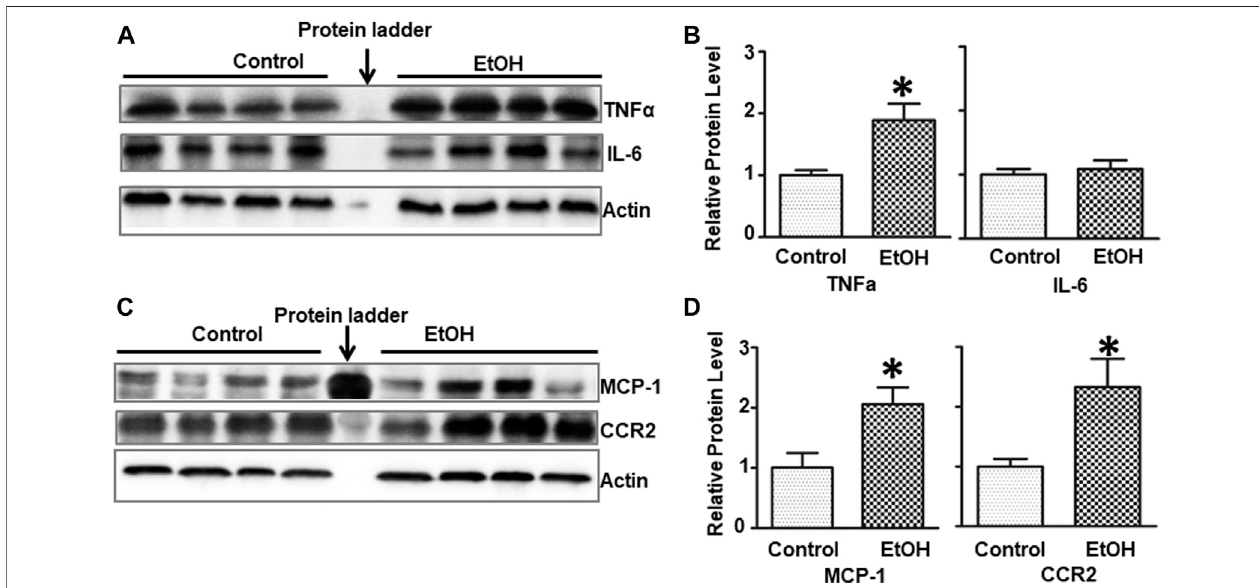
FIGURE 5 | Effects of chronic alcohol exposure on in fl ammatory cytokines/chemokines in the brain. (A) The expression of IL-6 and TNF α in the brain was determined with IB. (B) The relative expression ofIL-6 and TNF α was quanti fi ed as described above. Each data point was the mean ± SEM; n (cid:2) 4. * p < 0.05, statistically signi fi cant difference from the control group. (C) The expression of MCP-1 and CCR2 in the brain was determined with IB. (D) The relative expression of MCP-1 and CCR2 was quanti fi ed. Each data point was the mean ± SEM; n (cid:2) 4. * p < 0.05, statistically signi fi cant difference from control group.